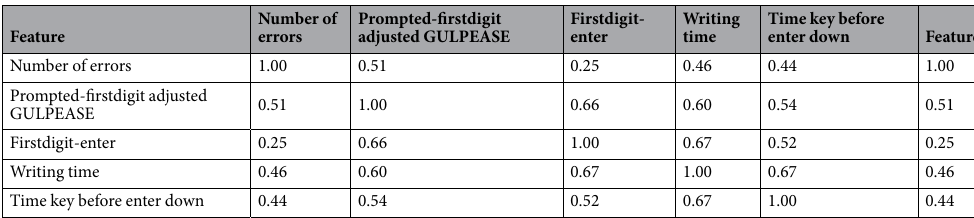
Table 4. This table reports the correlation matrix among the five final